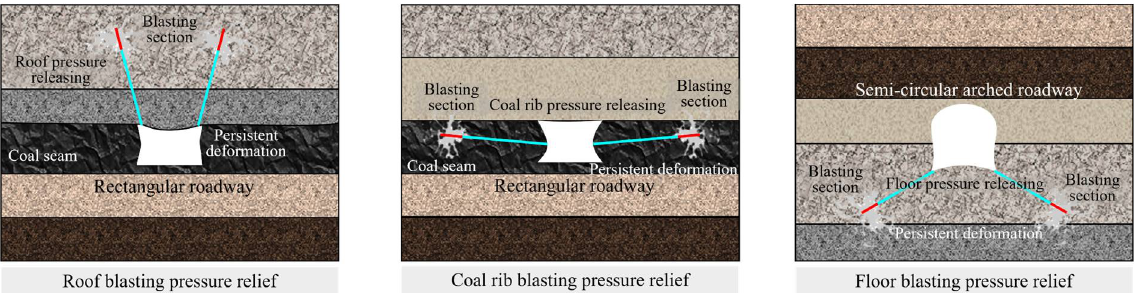
Figure 17. Blasting pressure relief technology for